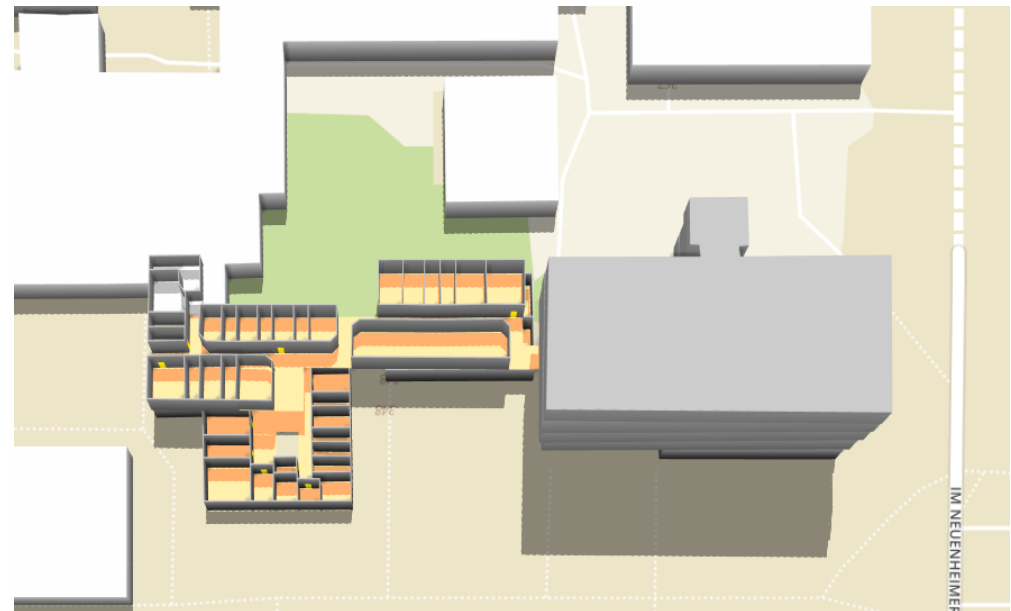
Figure 15. 3D visualization of the Geography building.